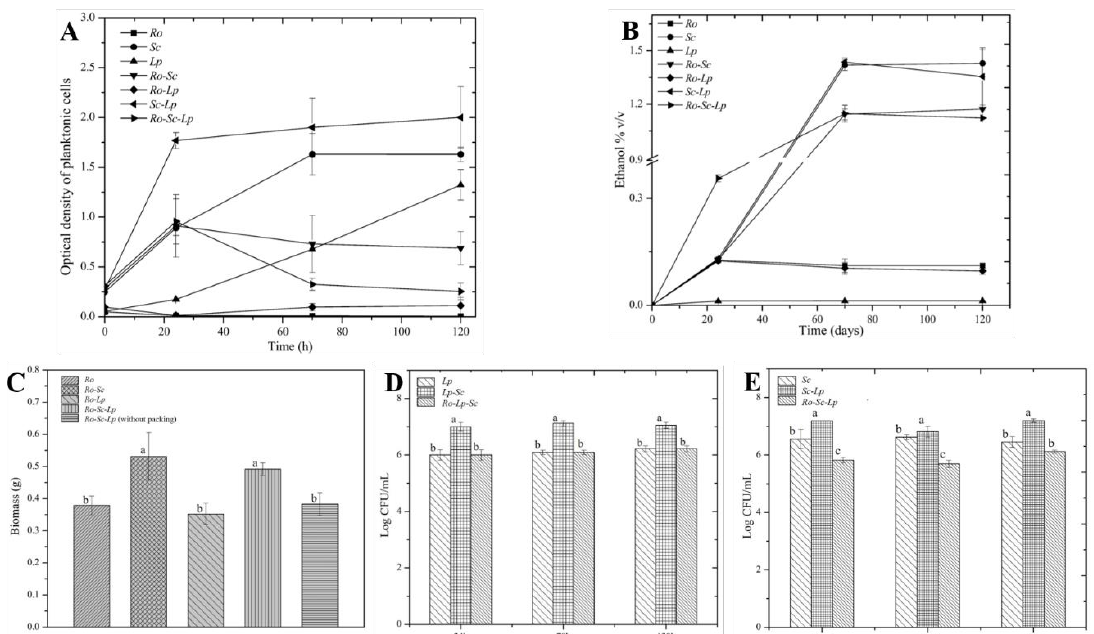
Figure 3. Biofilm and microbial evolution during single and co-culture in biofilm reactor. ( A ) Optical density OD of the planktonic phase. ( B ) Ethanol production. ( C ) Total biomass of the biofilm attached on packing and without packing after 70 h. ( D ) L. plantarum and ( E ) S. cerevisiae plate count while in the planktonic phase. Means with the same letter are not significantly different from each other (p < 0.05).